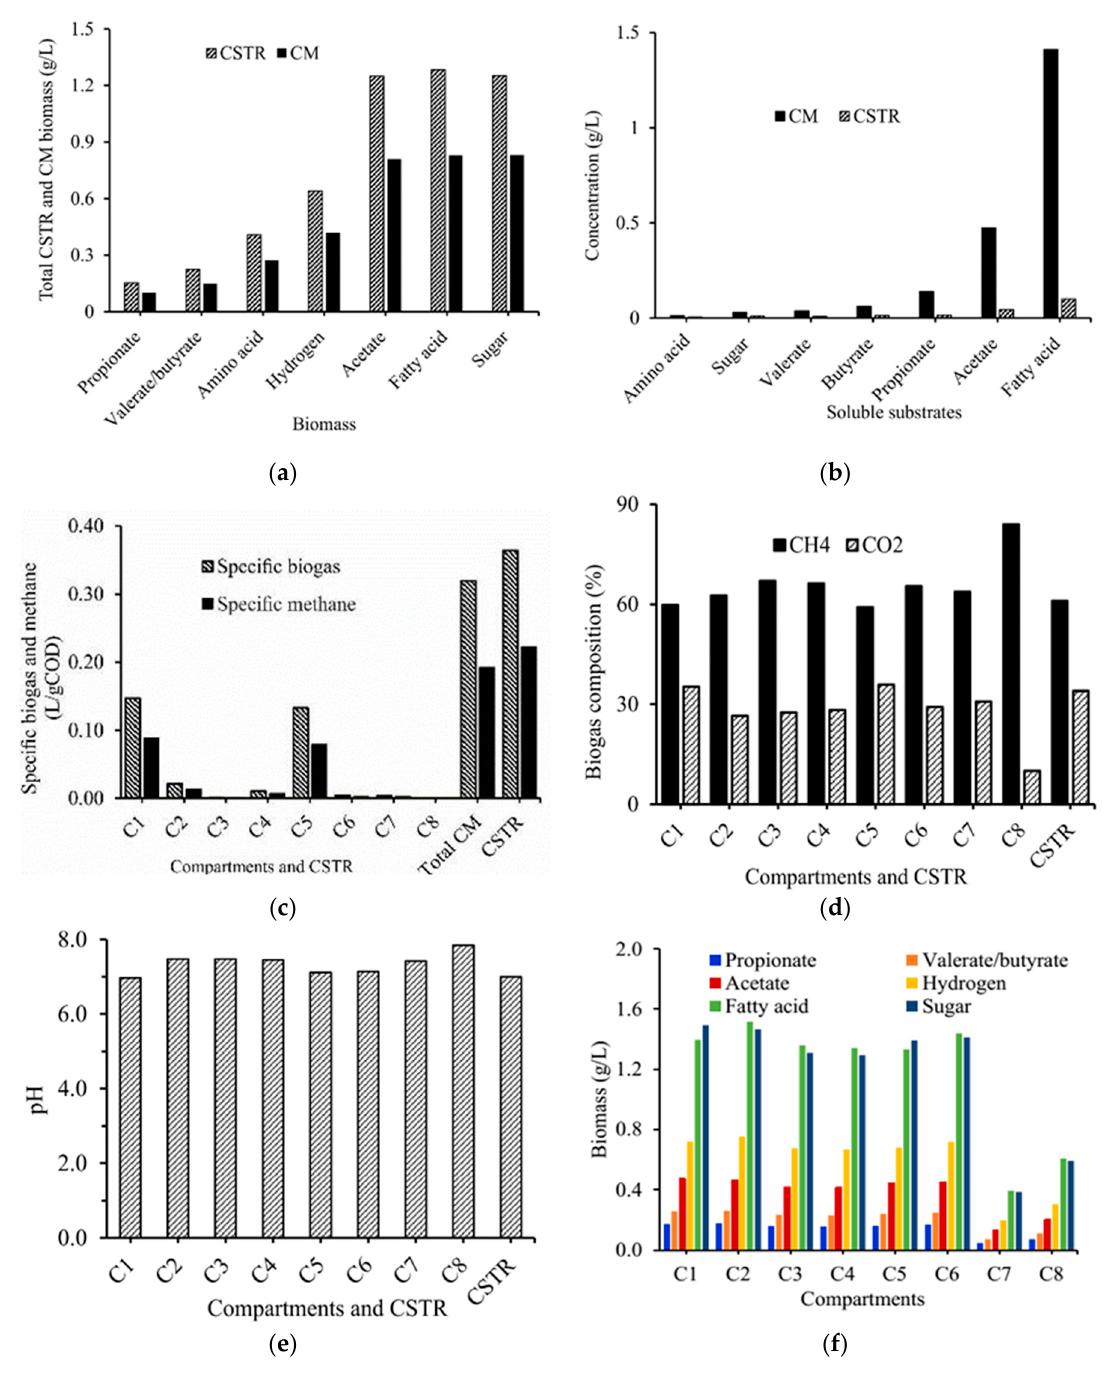
Figure 6. ( a ) Total biomass concentration; ( b ) undigested soluble substrates at the outflow from the CM; ( c ) specific biogas and methane production; ( d ) biogas composition; ( e ) pH distribution; and ( f ) biomass concentration per compartment in the CM digester.